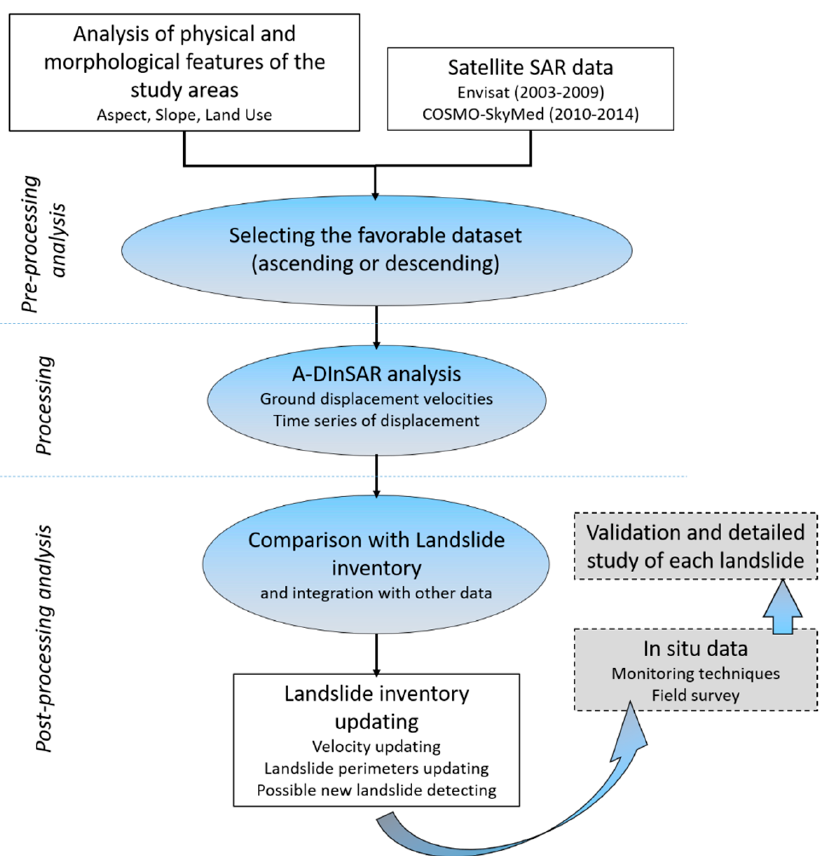
Figure 8. Methodology and the main steps of this work: (i) Pre-processing phase, (ii) the processing and (iii) the post-processing analysis. The last two boxes in grey represent the validation phase, that is out the scope of this work.